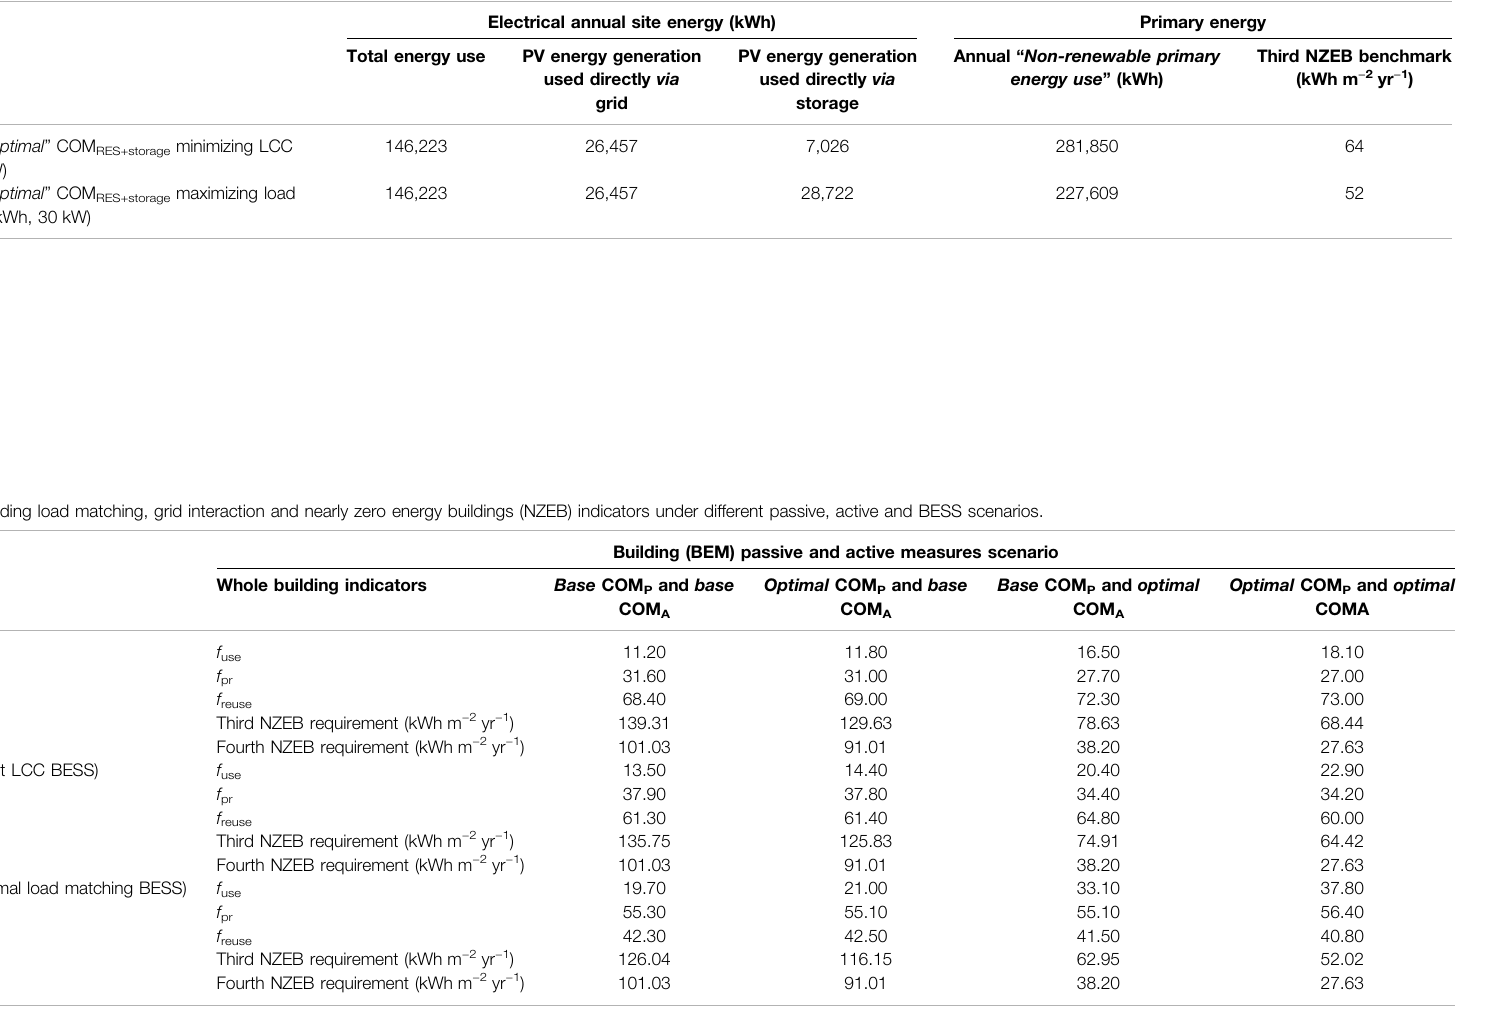
TABLE 5 | Derivation of the third nearly zero energy buildings (NZEB) benchmark indicator using different “ optimization ” criteria.